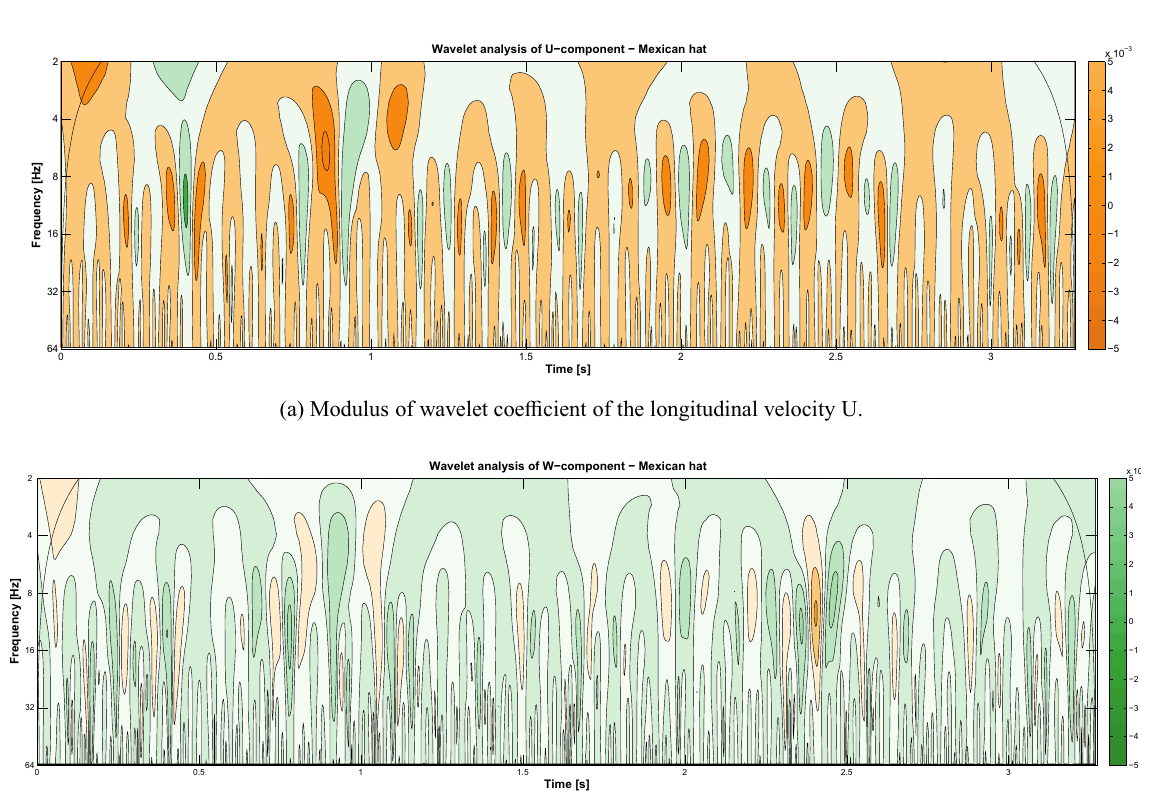
Fig. 5: Wavelet analysis with Mexican hat as a mother wavelet function applied to velocity time-series from point X / H = 0, Z / H =